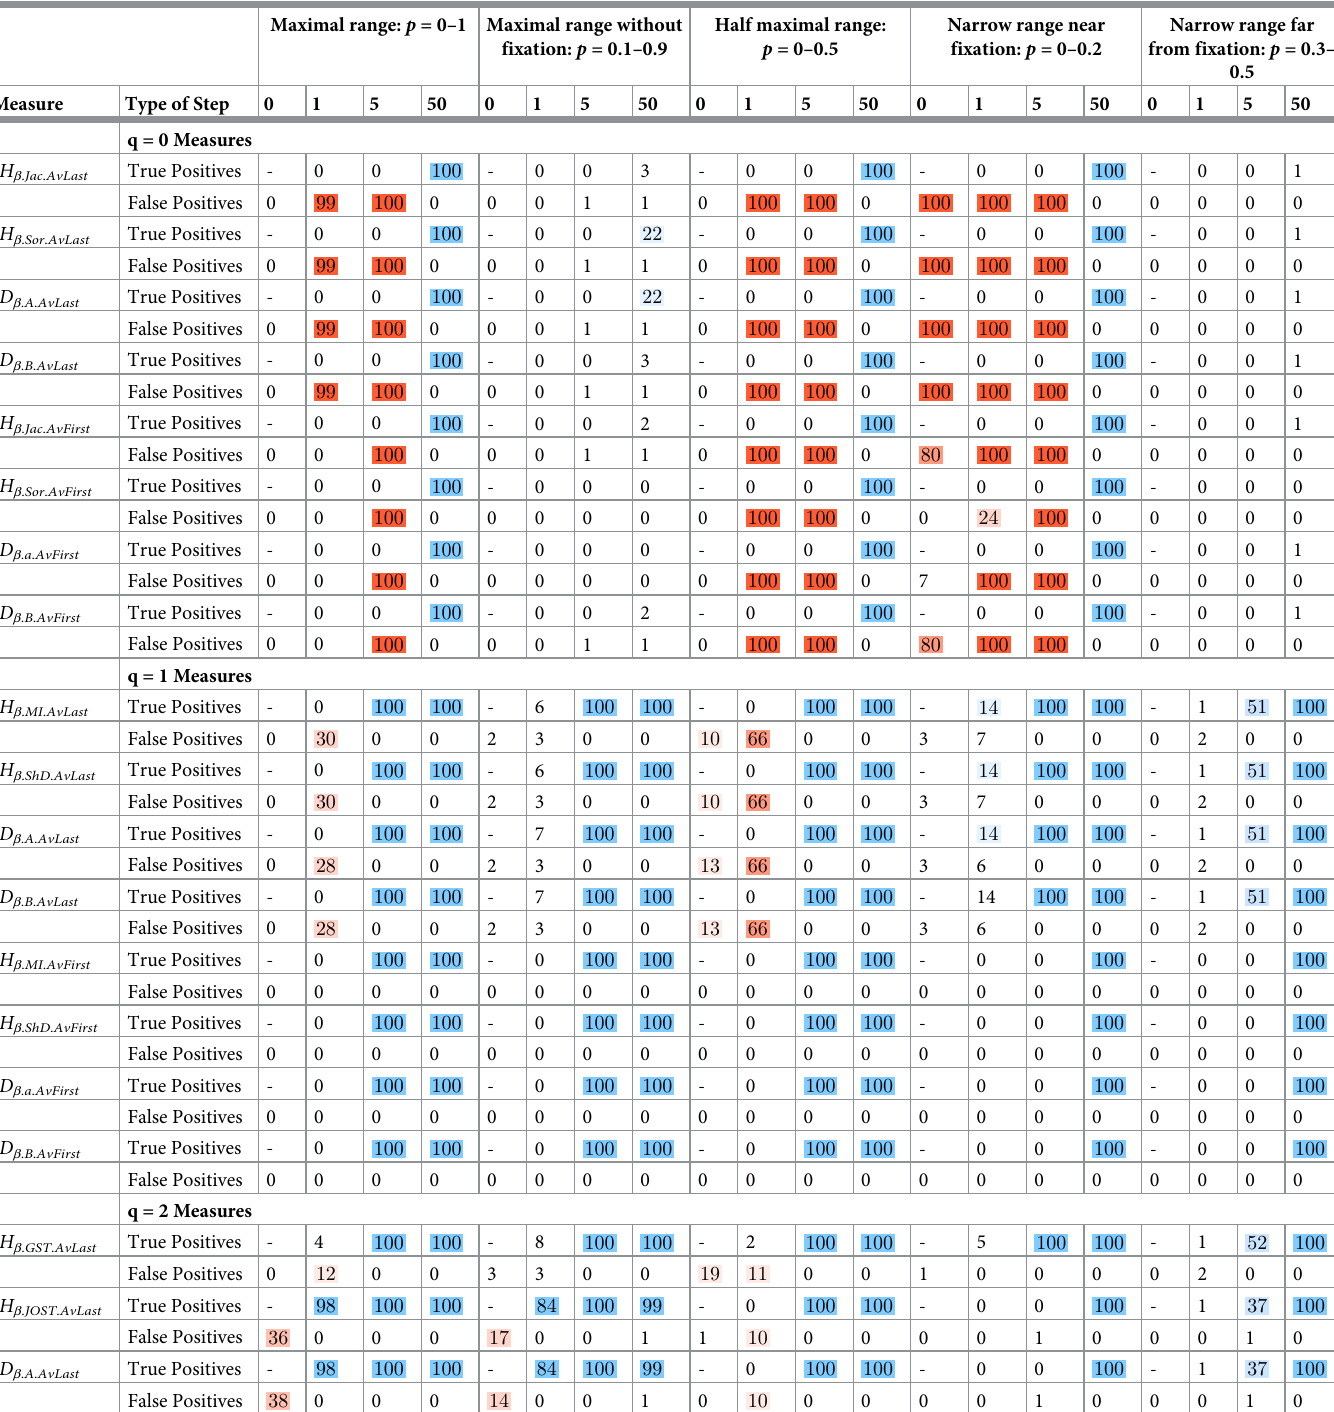
Table 2. Step detection sensitivity of all diversity measures for standard conditions across five allele proportion treatments ( p = 0–1, p = 0.1–0.9, p = 0–0.5, p = 0–0.2, p = 0.3–0.5), each with four step treatments (linear– 0, gentle step– 1, moderate step– 5, steep step– 50). Both true positives (where a step was detected at the correct location, d = 0.5) and false positives (where a step is detected at the wrong location or any location for the linear treatments) are shown. The remaining values (out of 100) for each treatment were simulations where no step was detected (true negatives for the linear treatments, false negatives for the step treatments). Darker blue represent higher numbers of true positives out of 100 simulations, darker red represents higher numbers of false positives out of 100